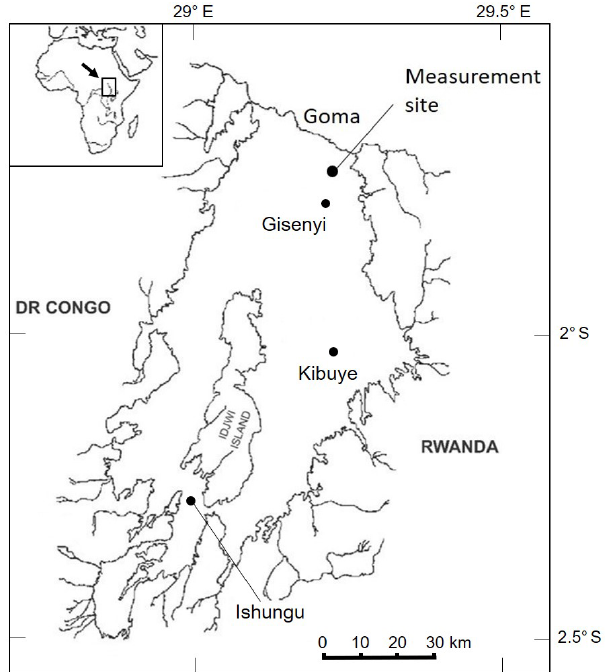
Figure 3. Map of Lake Kivu showing the location of the mea- surement site. Locations of previous campaigns mentioned in the discussion section are also reported (named Gisenyi, Kibuye and